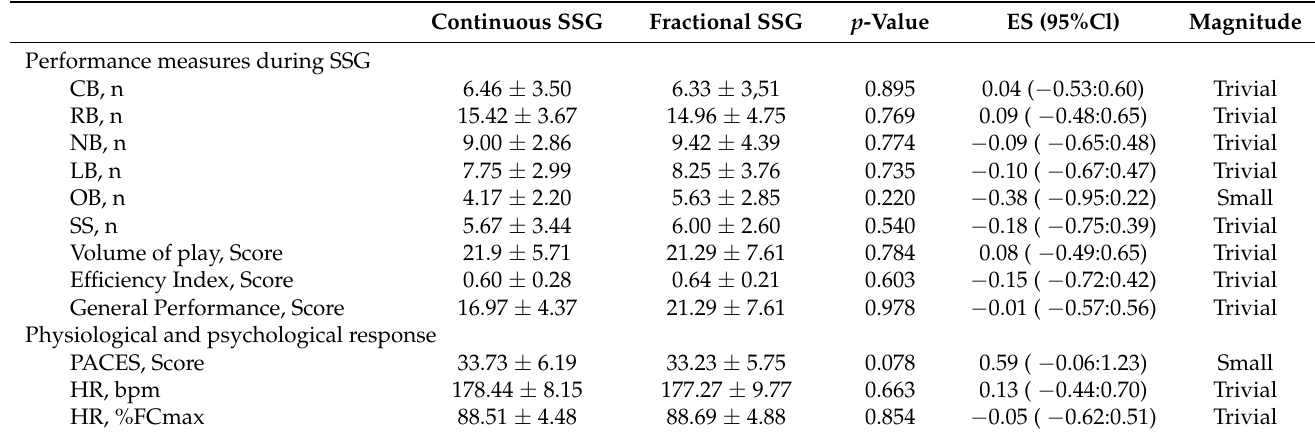
Table 2. Performance in the continuous and fractional